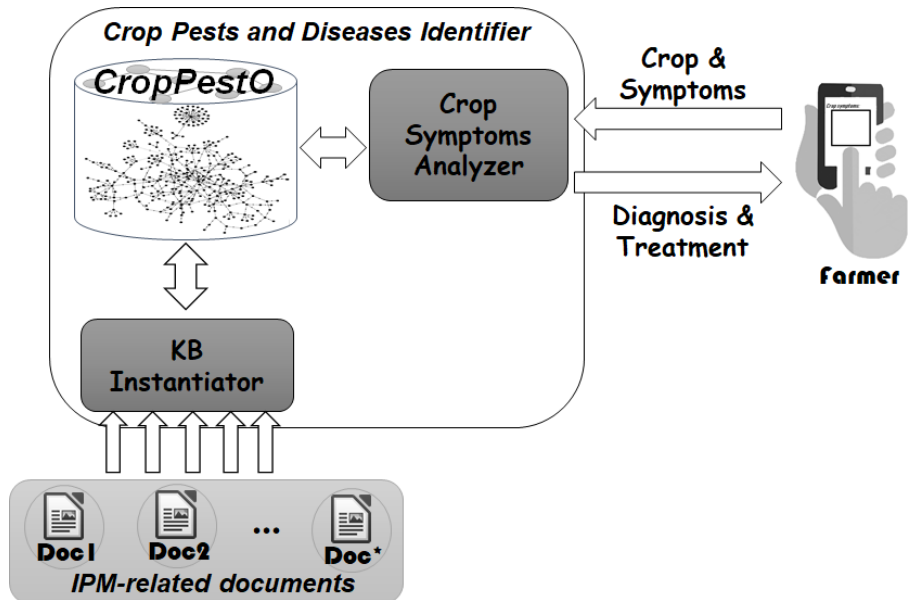
Figure 1. Proposed functional architecture framework for pests and diseases identification from natural language text.